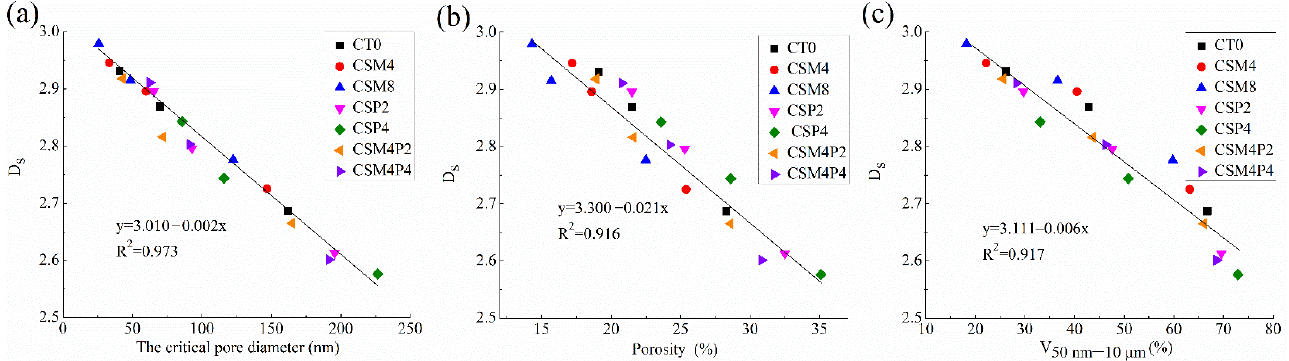
Figure 8. The correlation between D s and ( a ) the critical pore diameter, ( b ) porosity and ( c ) V 50 nm–10 μ m of